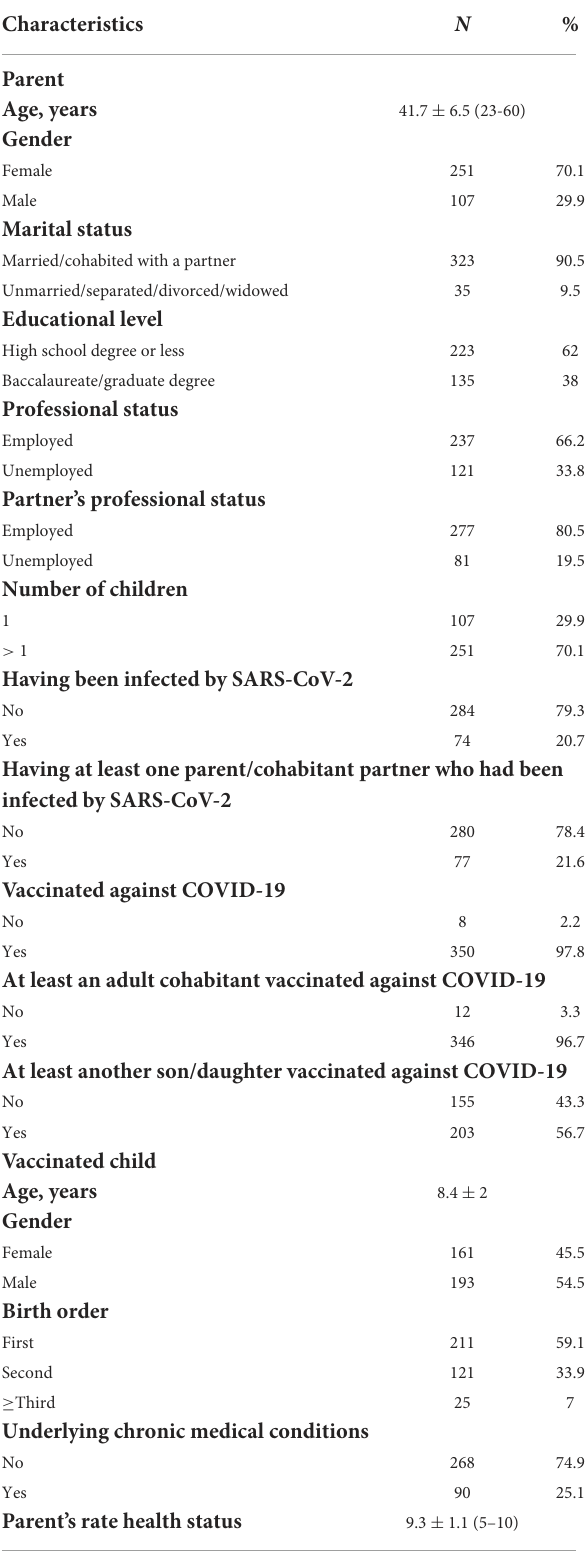
TABLE 1 Socio-demographic and general characteristics of the study